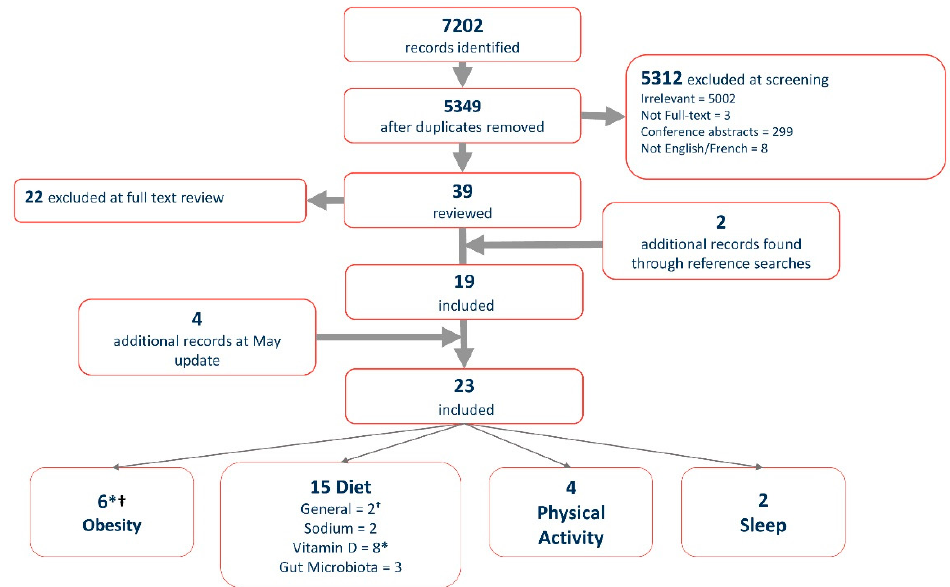
Figure 1. Modified PRISMA Chart. * Articles included in vitamin D and obesity sections: Brenton (2014), Gianfrancesco (2017), and Yamamoto (2018); † articles included in dietary factors and obesity sections: Pakpoor (2007): General diet and obesity.